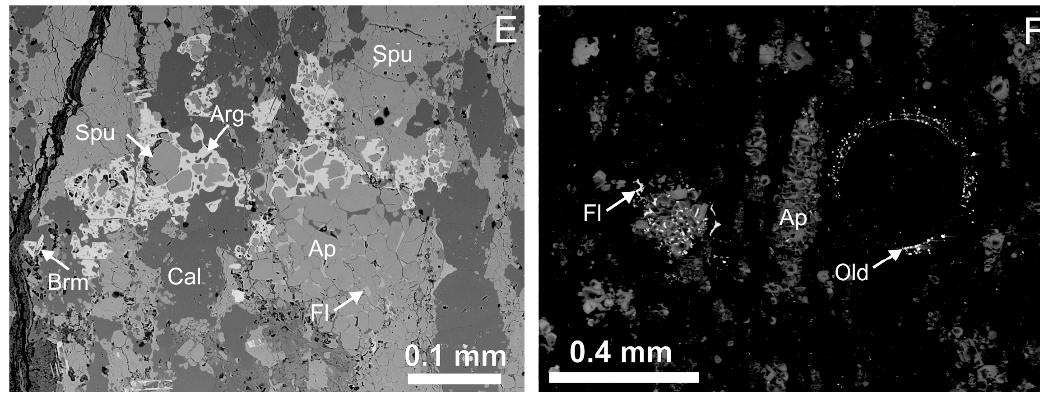
Figure 5. Poikilitic crystals of ariegilatite in gehlenite-larnite rock ( A ), where it also forms reaction rims on fluorapatite, Daba-Siwaqa, Jordan (Sample No. YV595 ); poikilitic crystals of ariegilatite in spurrite rock ( B ), Daba-Siwaqa, Jordan ( SS20b ); replacement of flamite by ariegilatite with exsolution structures ( C ), Ma’ale Adummim, Palestinian Autonomy ( MA5b ); apatite-spurrite rock with ariegilatite and channels filled with calcite ( D ). The fragment magnified in ( E ) is shown in the frame; Gurim Anticline, Negev Desert, Israel ( IS129 ); xenomorphic aggregates of ariegilatite with spurrite inclusions (E); cathodoluminescence image of the area shown in (D) ( F ), round shape of the channel, the walls of which are incrusted by oldhamite, having intensive luminescence. Arg = ariegilatite, Ap = fluorapatite, Brm = brownmillerite, Cal = calcite, Etr = ettringite, Flm = flamite, Fl = fluorite, Ghl = gehlenite, Lrn = larnite; May = fluormayenite-fluorkyuygenite, Old = oldhamite, Sp = spinel, Spu = spurrite.